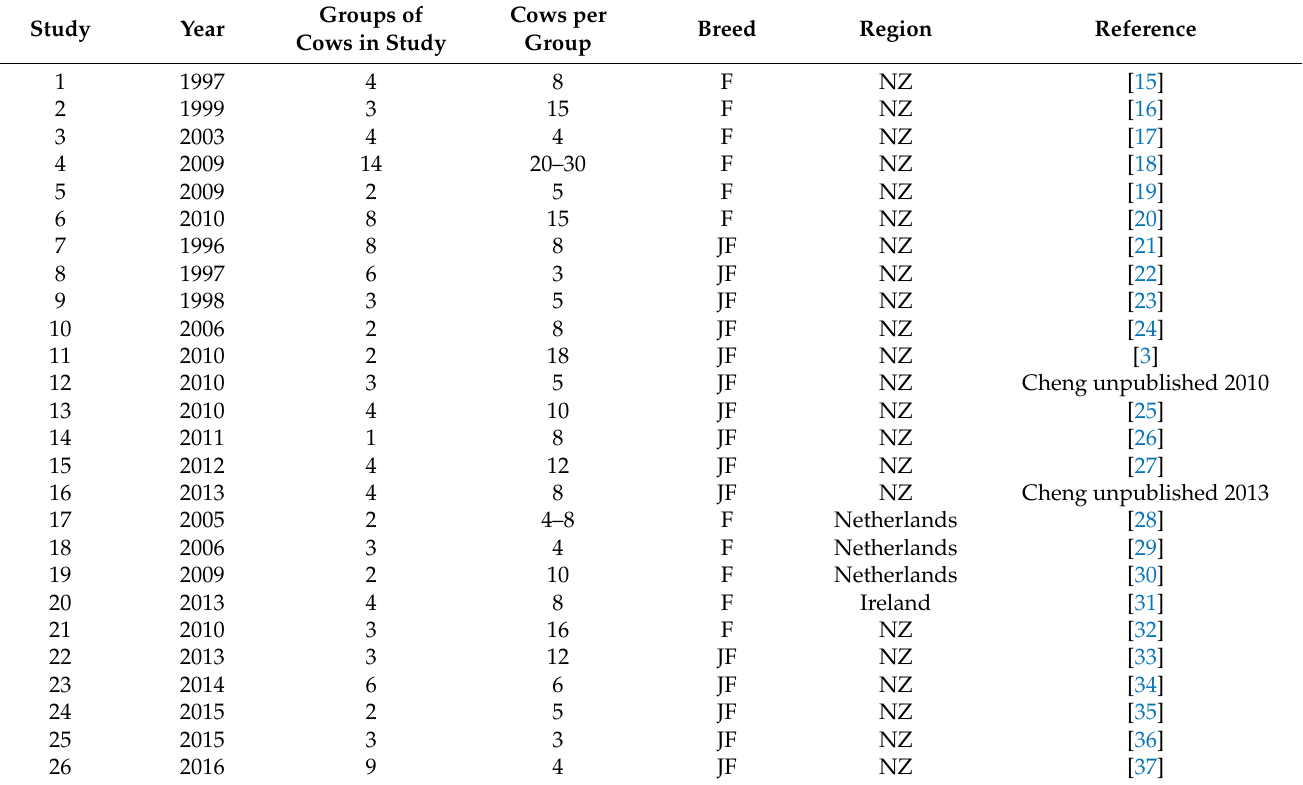
Table 1. Summary information about sources of data used in model development (Trial 1–16) and evaluation (Trial 17–26).